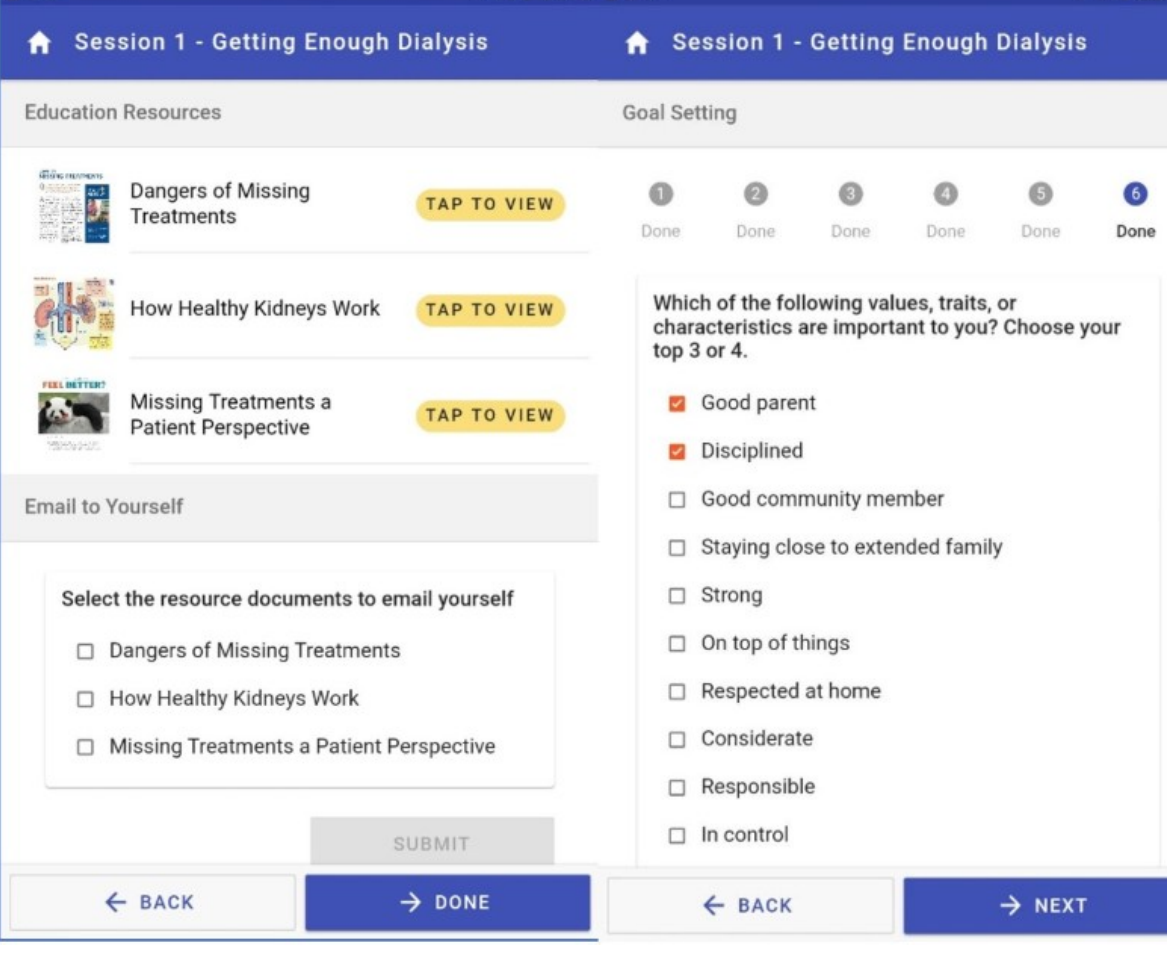
Figure 3. Screenshots from the tablet-based intervention: supplemental materials related to each learning module that patients can email themselves to review outside of dialysis hours (left panel); goal-setting module wherein patients select values, traits, or characteristics most important to them (right